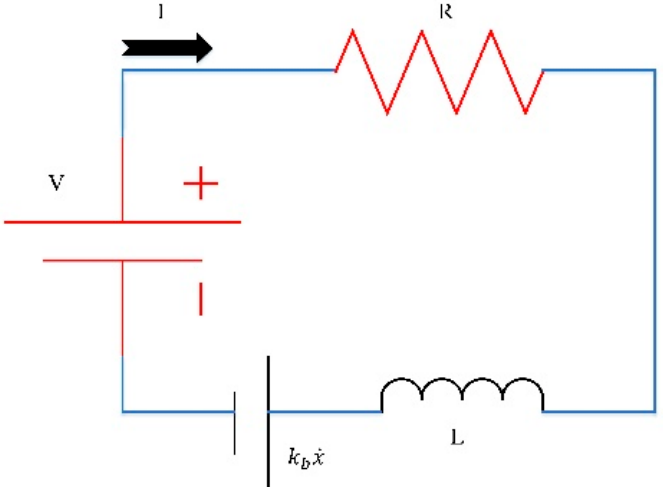
Figure 8. An equivalent RL circuit of VCA. Table 2. Experimental system specification.